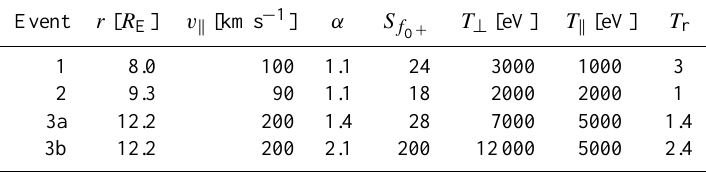
Table 1. Observed O + parameters: altitude r , parallel velocity v k , power law fitting parameter α around the local gyrofrequency, electric power spectral density S f (given in (mVm − 1 ) 2 Hz − 1 ), perpendicular temperature T ⊥ , parallel temperature T k and perpendicular-to- O + parallel temperature ratio T r .